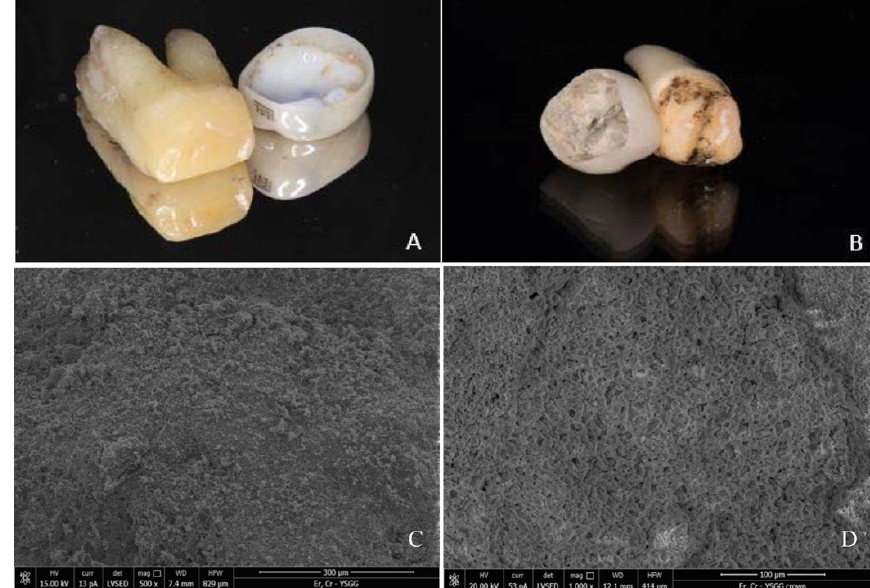
Figure 3. Clinical view of the tooth and crown following laser-debonding from primary ( A ) and permanent ( B ) tooth. Tooth surface ( C ) and intaglio surface of the crown ( D ) appeared to be undamaged and covered by the residual cement on the SEM analysis.